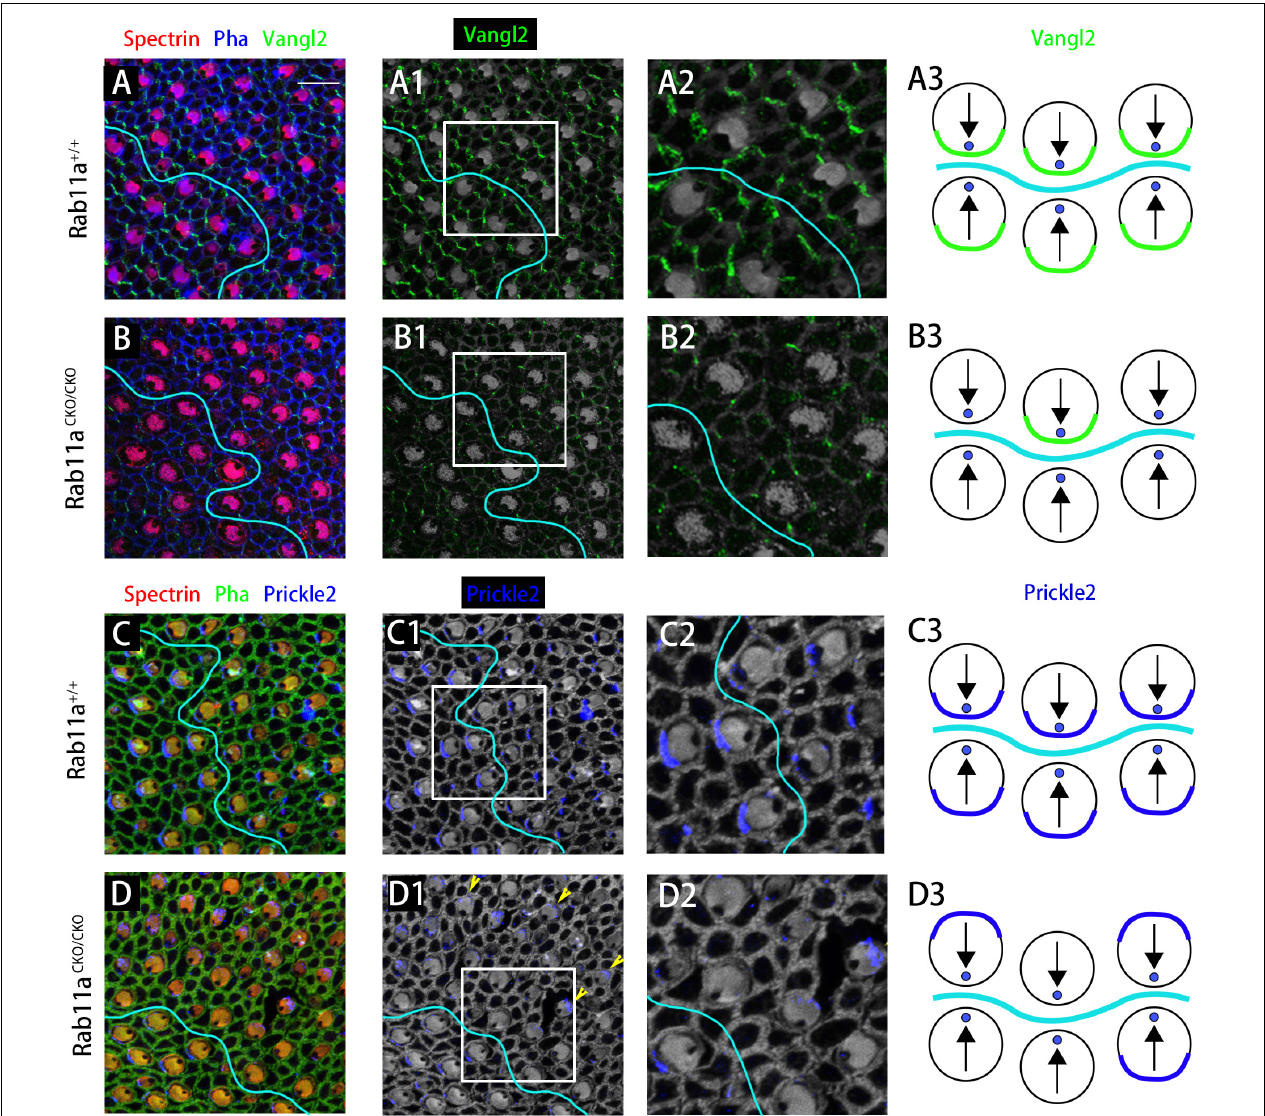
FIGURE 5 | The subcellular distributions of core planar cell polarity (PCP) proteins are affected in Rab11a mutant utricles. (A,A1,A2) Vangl2 immunolabeling was enriched at cell boundaries in the wild-type utricular maculae. Asymmetrical protein localization was evident at many cell boundaries. (B,B1,B2) Vangl2 protein was significantly reduced from apical cell boundaries in Rab11a CKO / CKO utricles. (C,C1,C2) Prickle2 was enriched at hair cell/support cell boundaries throughout the wild-type utricle. For cells located reversely across in different side of LPR, Prickle2 located in the same side of hair cells. (D,D1,D2) In Rab11a CKO / CKO mice, the distribution of Pk2 changed in a region-specific manner. Prickle2 moved to the opposite side of hair cells located in two regions across the LPR (yellow arrowheads). (A3,B3,C3,D3) Schematic view of Vangl2 and Prickle2 expression in control and Rab11a CKO / CKO utricle. For primary panels in (A–B2) , hair cell stereociliary bundles were marked with phalloidin (blue), the actin-rich cuticular plate of hair cells was labeled with an antibody to β -spectrin (red), and with an antibody to the core PCP protein Vangl2 is shown in green. In (C–D2) , phalloidin is shown in green, β -spectrin in red, and core PCP protein Prickle2 in blue. Scale bars: 10 µ